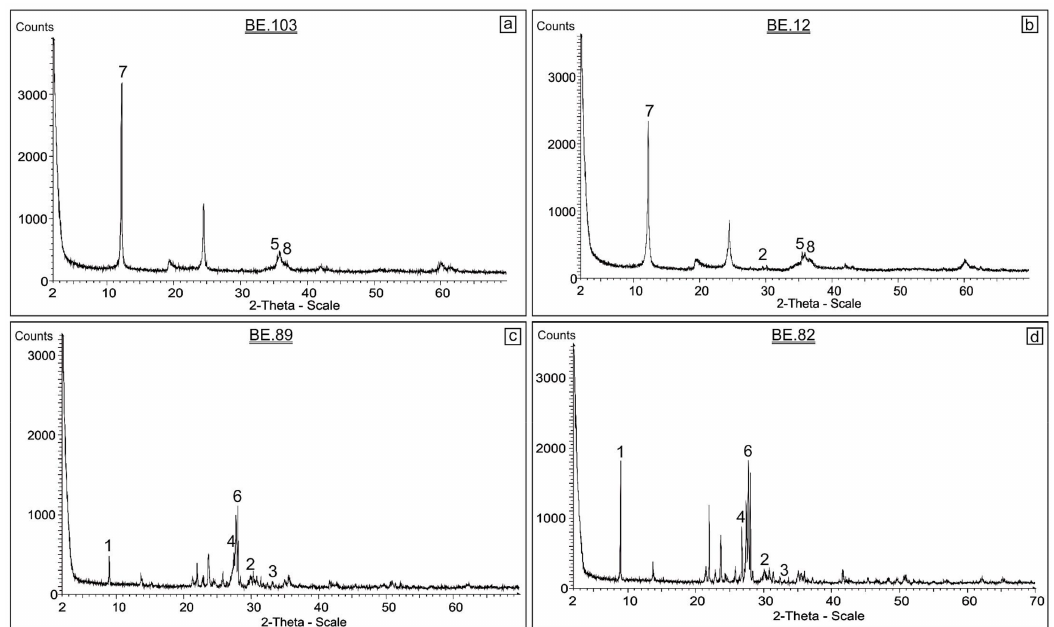
Figure 4. Representative X-ray diffraction patterns of the studied serpentinites ( a , b ) and andesites ( c , d ). Sample numbers are indicated as insets (1: mica, 2: diopside, 3: hematite, 4: K-feldspar, 5: magnetite, 6: plagioclase, 7: serpentine, 8: